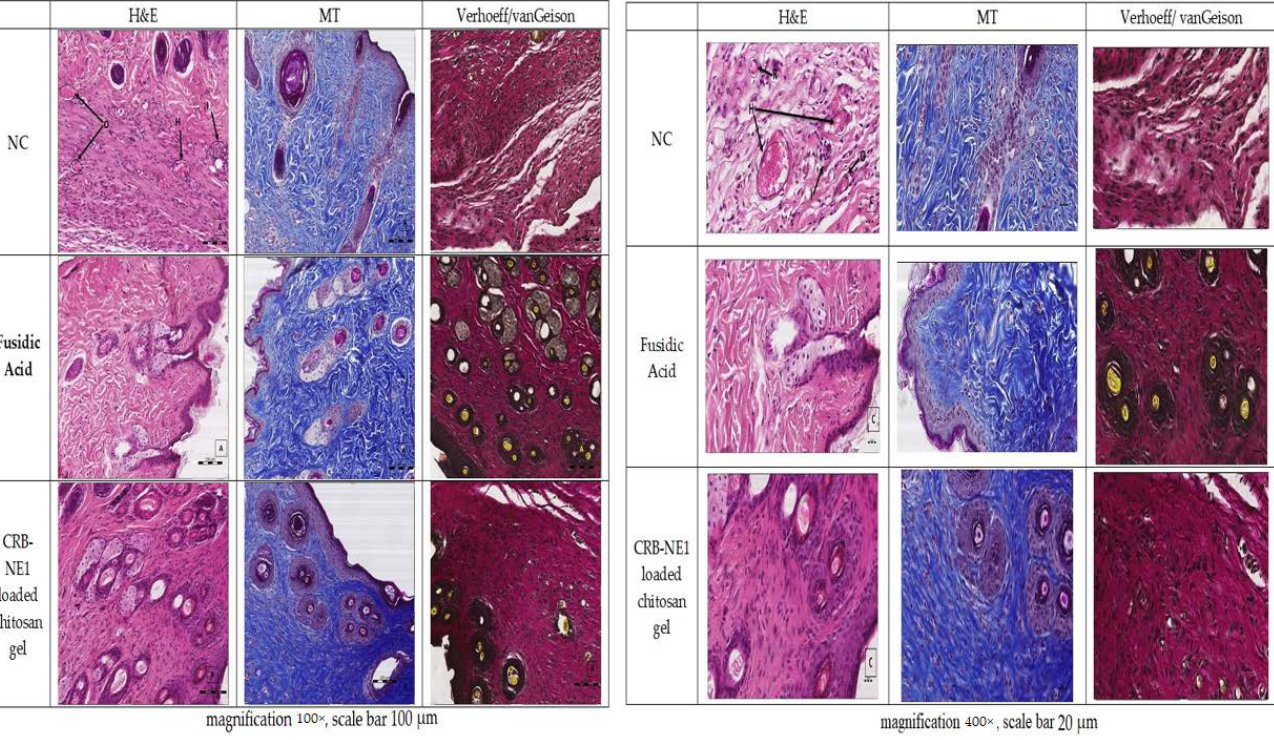
Figure 8. Photomicrographs of skin samples of 21 days after treatment with CRB-NE1 loaded chitosan gel and fusidic acid gel with hematoxylin and eosin (H&E) stain, Masson Trichrome (MT) stain, and Verhoeff/vanGeison stain (magnification 100 × and 400 × ). Abbreviations indicate Hyperemia (H), presence of red blood cells within tissue outside blood vessels which indicate hemorrhage (R), Occlusion of blood vessels with hyaline material (O), and infiltration of tissue by inflammatory cells